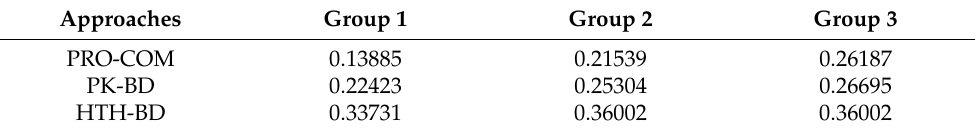
Table 20. The MSE considering the three approaches as well as the different groups of products tested. Approaches